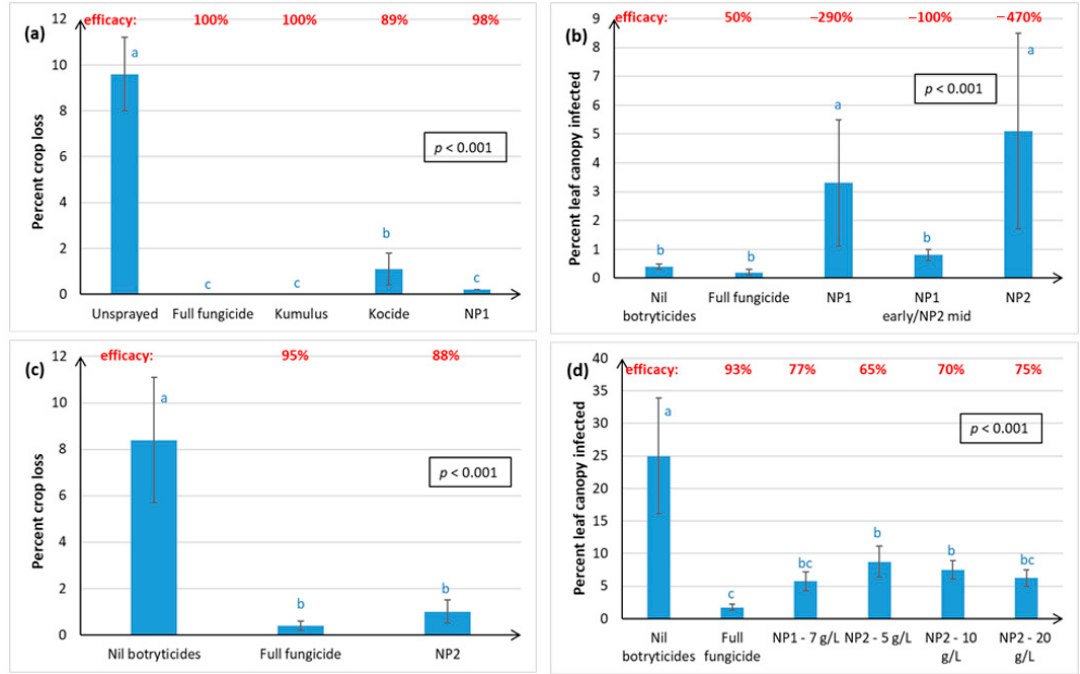
Figure 6. Percentage crop loss of fruit, or percentage leaf canopy infected by powdery mildew (PM) in Chardonnay and Riesling grape varieties. Crop loss was calculated as described in Figure 2, and efficacy as outlined in Figure 1. Percent canopy infected was the product of incidence (%leaves infected) × severity (%leaf area infected)/100. Treatments are described in full in Tables S1 and S2, and briefly in Figures 1 and 2. Each graph represents data from a separate trial, set up in a randomised block resign, with error bars indicating standard errors, boxed values showing probabilities obtained from ANOVA, and different letters indicating statistically significant differences from pairwise likelihood ratio tests, which are only presented when the ANOVA p ≤ 0.05. The concentration of the active ingredient in the NP formulation is indicated in parentheses for each specific experiment. ( a ) Chardonnay, Season 1, Hawke’s Bay site, NP1 (7 g/L); ( b ) Chardonnay, Season 2, Hawke’s Bay site, NP1 (7 g/L) and NP (15 g/L); ( c ) Chardonnay, Season 3, Hawke’s Bay site, NP2 (5 g/L); ( d ) Riesling, Hawke’s Bay, NP1 (7 g/L) and NP2 (5, 10 and 20